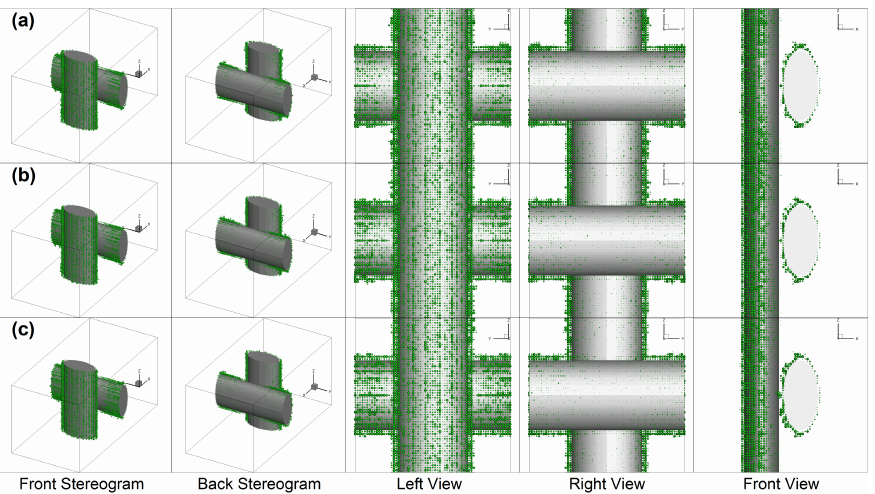
Figure 13. Dendrite structures with different inlet fluid velocities: ( a ) Case 2, u in = 0.1 m/s; ( b ) Case 10, u in = 0.2 m/s; ( c ) Case 11, u in = 0.3 m/s.